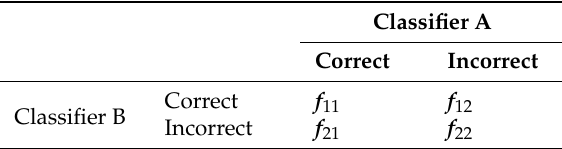
Table 6. Assessment of the statistically significant difference between two classifications using McNemar’s